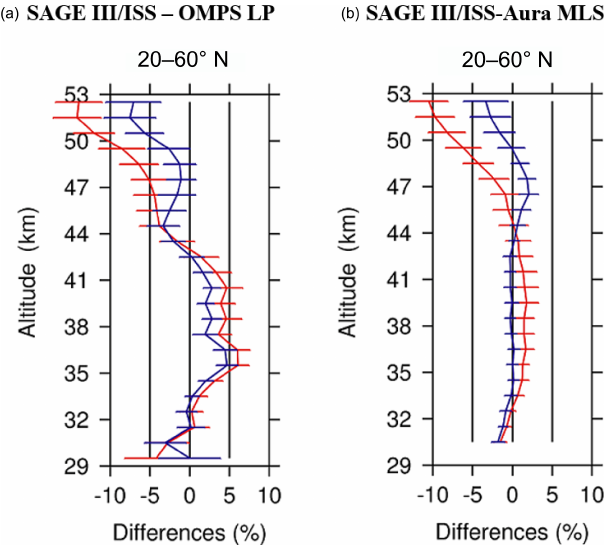
Figure 8. Profile of mean differences between SAGE III/ISS and the OMPS Limb Profiler (a) and Aura MLS ( b , daytime measure- ments only) averaged from 20 to 60 ◦ N, expressed as a percentage difference as a function of altitude (km). Sunrise and sunset profiles are included in the mean difference. The red curve shows the orig- inal mean difference, and the blue curve shows the same compari- son after using GDOC to adjust the SAGE profiles to an equivalent measurement time of 13:30LST to correspond to OMPS and Aura measurements. The error bars are the standard deviation (1 σ ; the SEM is smaller than the line width).